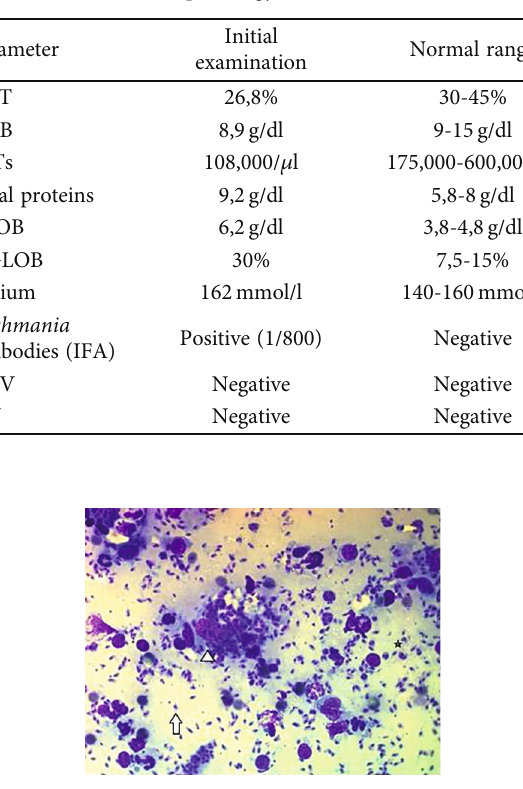
Figure 3: Photomicrography of the swelling of the forehead of the cat with leishmaniosis showing granulomatous in fl ammation with high number of Leishmania amastigotes, both intracellularly (arrowhead) and extracellularly (arrow). In some amastigotes, the basophilic rod-shaped kinetoplast is clearly visible (asterisk) (Di ff - Quick stain, x400).